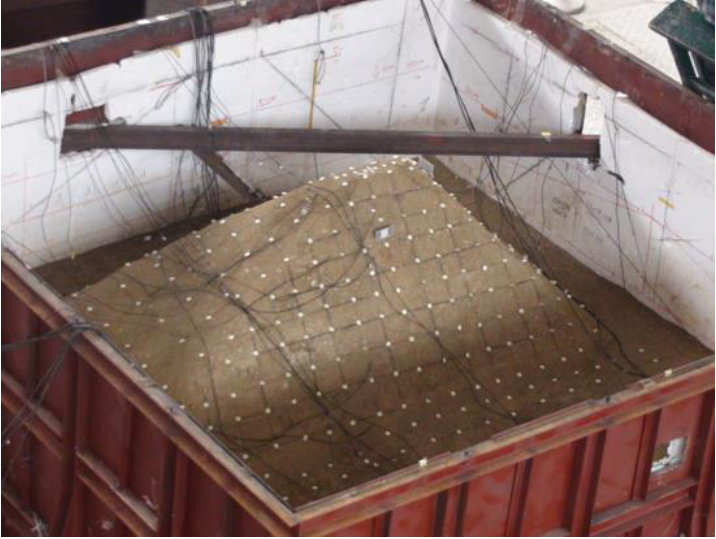
Figure 4. Shaking table test model of an isolated